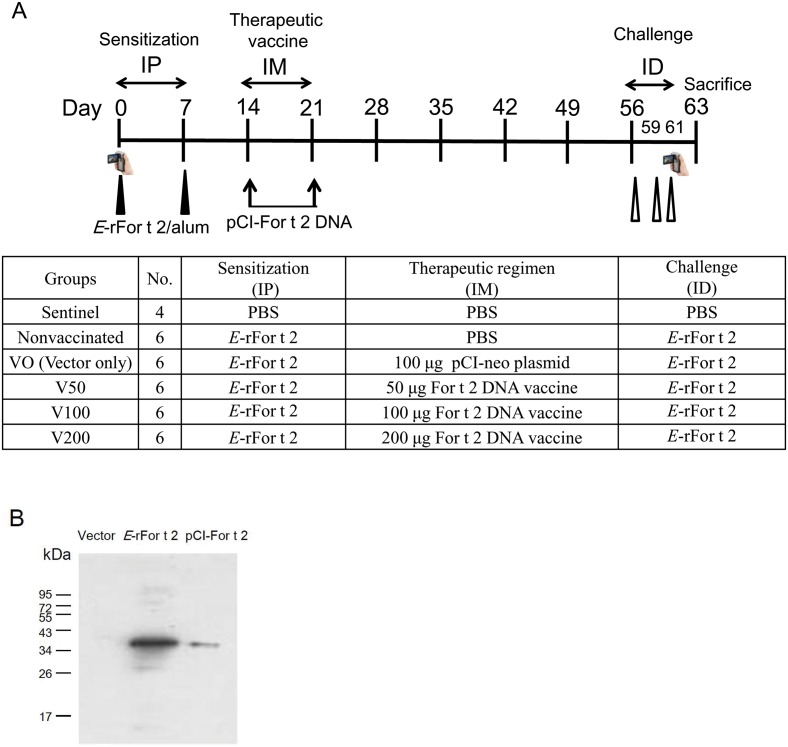
Experimental procedure.(A) Therapeutic regimen of For t 2 DNA vaccination in E-rFor t 2-sensitized mice. BALB/c mice received 2 intra-peritoneal injections of E-rFor t 2/alum on days 0 and 7. Subsequently, the sensitized mice were treated intra-muscularly with For t 2 DNA vaccine on days 14 and 21. From days 56 to 61 the mice were challenged intra-dermally (ID) with 3 doses of E-rFor t 2 on 3 consecutive days. Blood samples were collected bi-weekly from the retro-orbital venous plexus. The scratching behaviors of the mice were videotaped at days 0 and 61. All experimental mice were sacrificed on day 63. (B) Western blot analysis of culture supernatant from HaCaT cells transfected with empty vector or pCI-For t 2 using rabbit anti-E-rFor t 2 antibodies. E. coli-expressed recombinant protein was seen at 36 kDa as detected in the positive control.